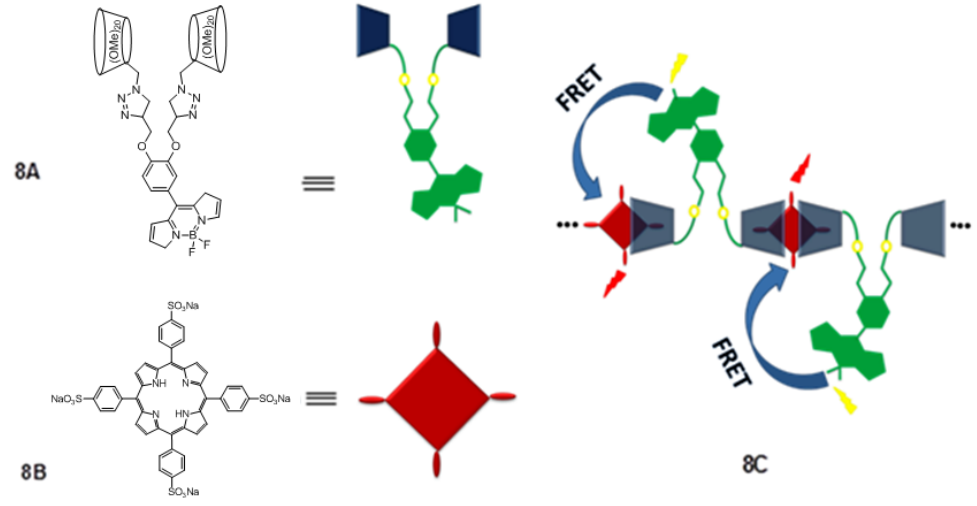
Figure 8. Representation of fluorescence resonance energy transfer (FRET) from modified cyclodextrin donor to porphyrin